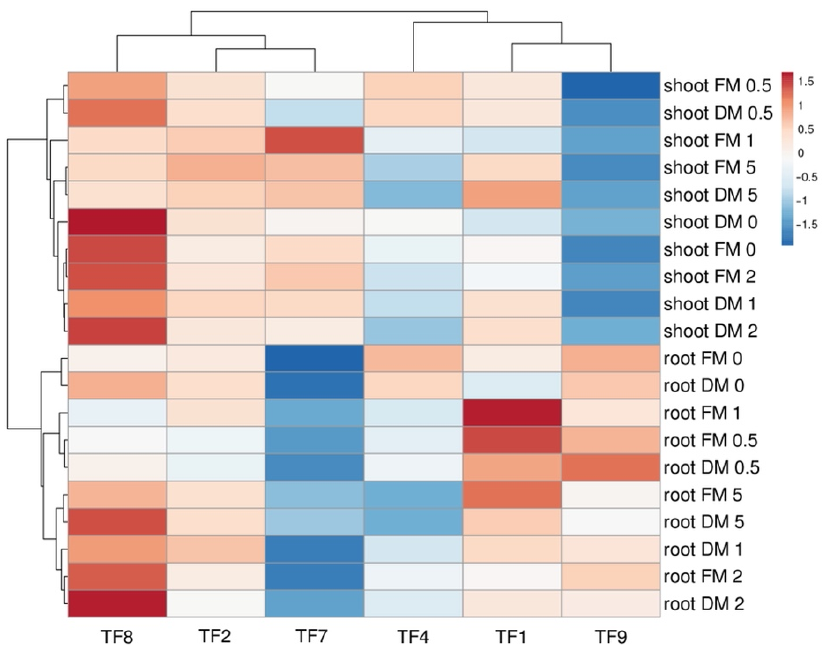
Figure 3. Principal component analysis on effect of increasing substrate salinity on shoot and root fresh mass and dry mass of Trifolium fragiferum plants of different accessions. ( A ), grouping according salinity levels; ( B ), grouping according accessions. Prediction ellipses are such that with probability 0.95, a new observation from the same group will fall inside the ellipse. Unit variance scaling was applied to rows; singular value decomposition with imputation was used to calculate principal components. X and Y axes show principal component one and principal component two that explain 66.5% and 28.9% of the total variance, respectively.